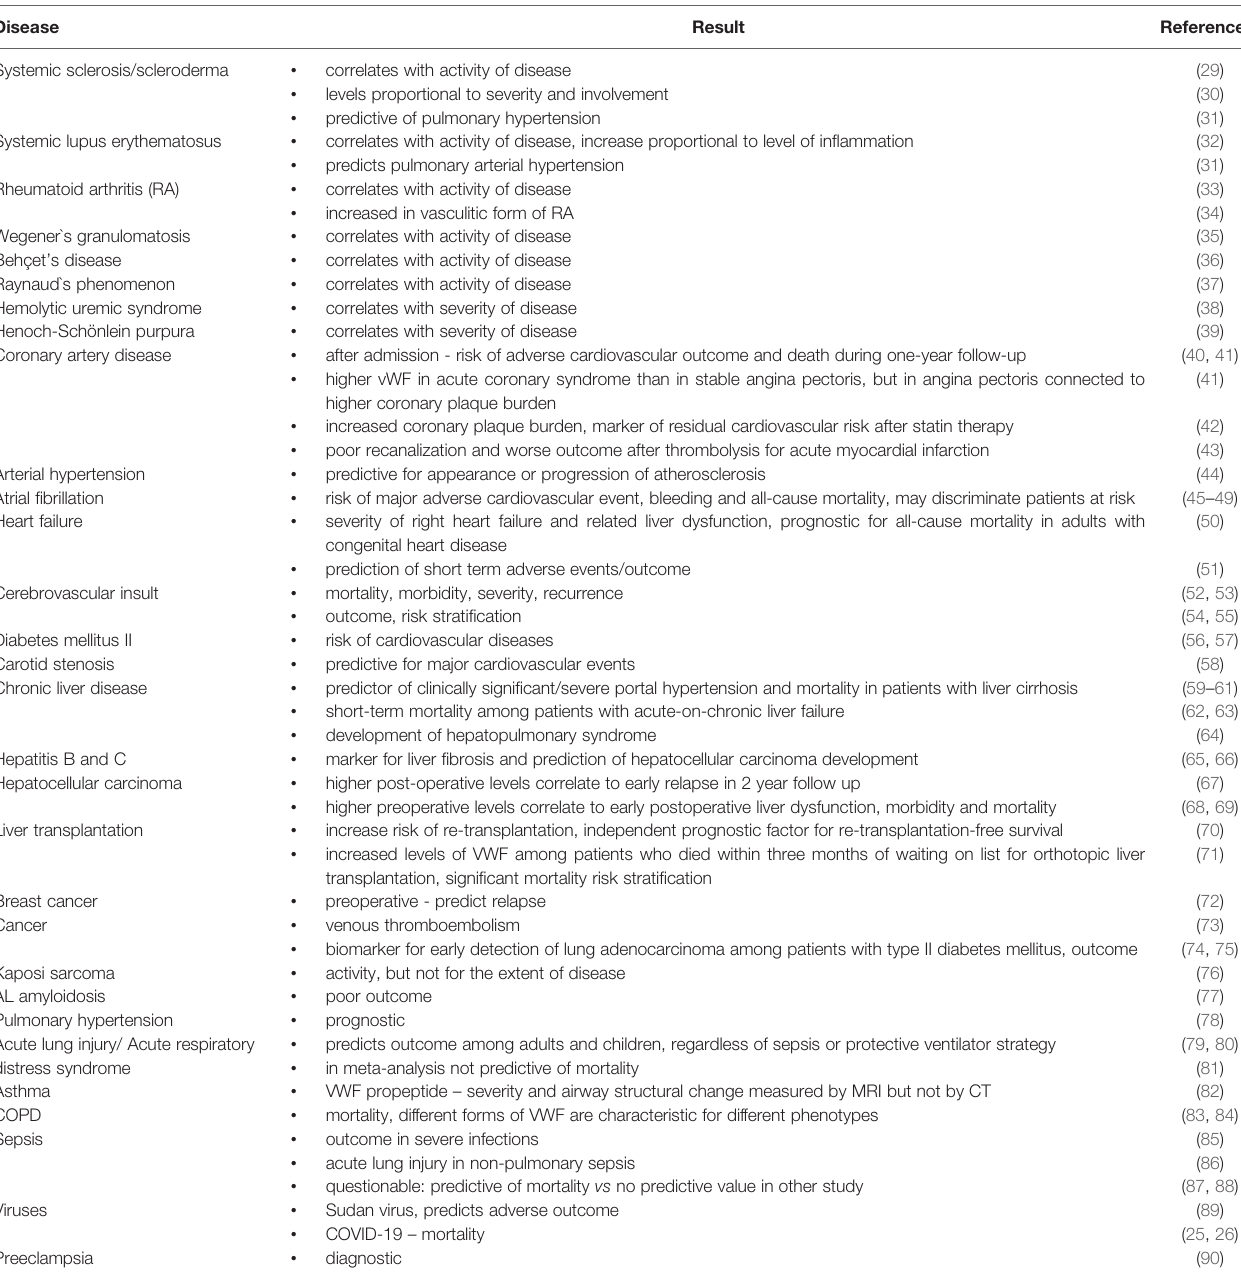
TABLE 2 | Reported biomarker potential of elevated VWF levels in different diseases/conditions. Disease